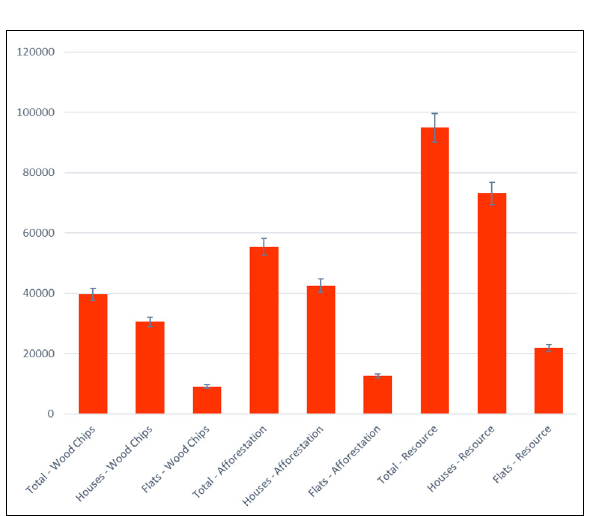
Figure 3: Potential number of 114-m² wood-based houses per annum, with 5% error bars.